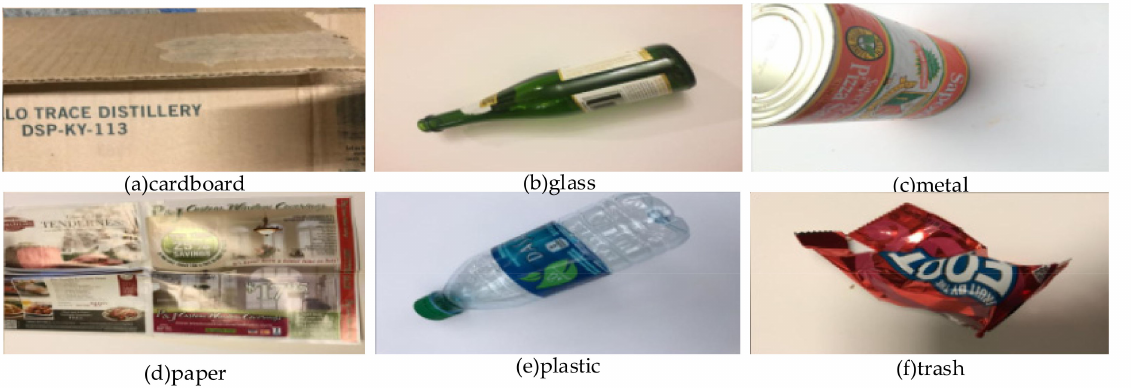
Figure 5. Some images from the TrashNet dataset. ( a ) Cardboard sample, ( b ) Glass sample, ( c ) Metal sample, ( d ) Paper sample, ( e ) Plastic sample, ( f ) Trash